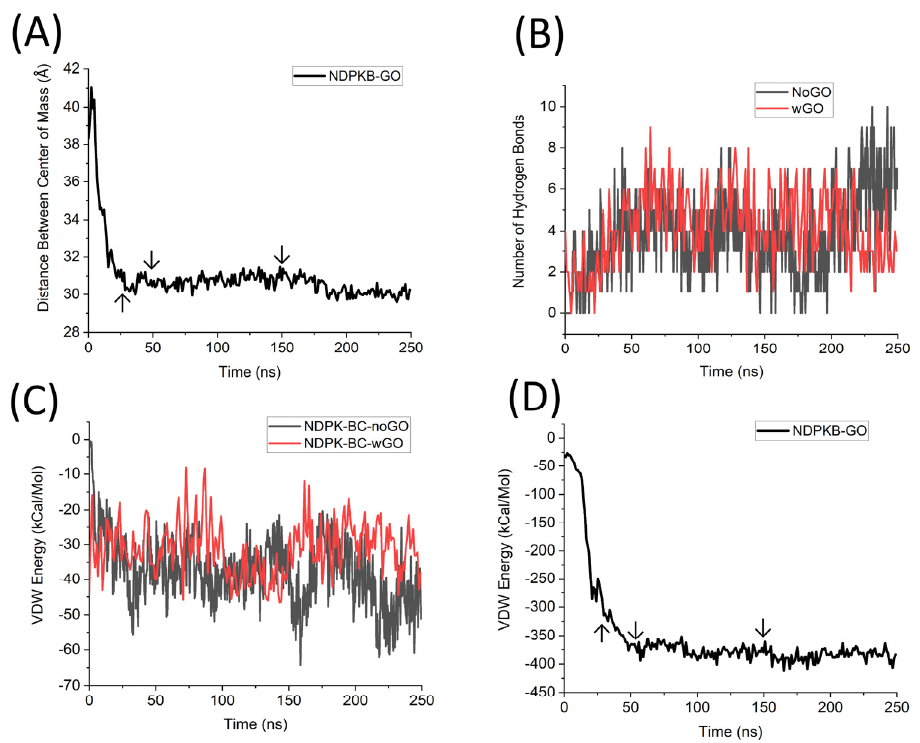
Figure 3. Stability and energetics analysis between NDPK-B, NDPK-C and graphene oxide: ( A ) Distance between the center of mass (COM) between NDPK-B and GO; ( B ) Number of hydrogen bonds between NDPK-B and NDPK-C in the presence and absence of GO; ( C ) Van der Waals (VDW) energy between NDPK-B and NDPK-C in the presence and absence of GO; ( D ) VDW energy between NDPK-B and GO. The three important milestones in the trajectory at 25 ns, 50 ns and 150 ns are shown on the plots using the arrowheads. Table 1. Intermolecular salt bridges between NDPK-B and